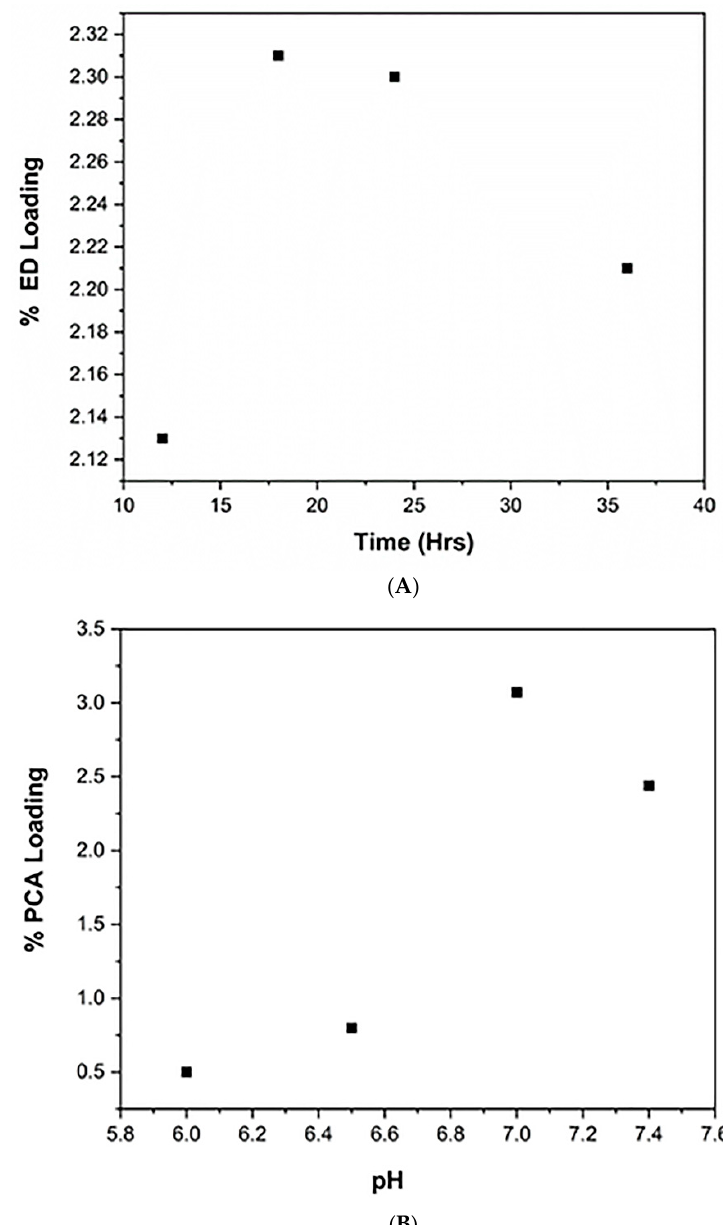
Figure 3. ( A ) Showing the effect of reaction time on ED loading. ( B ) Showing effect of reaction pH on PCA